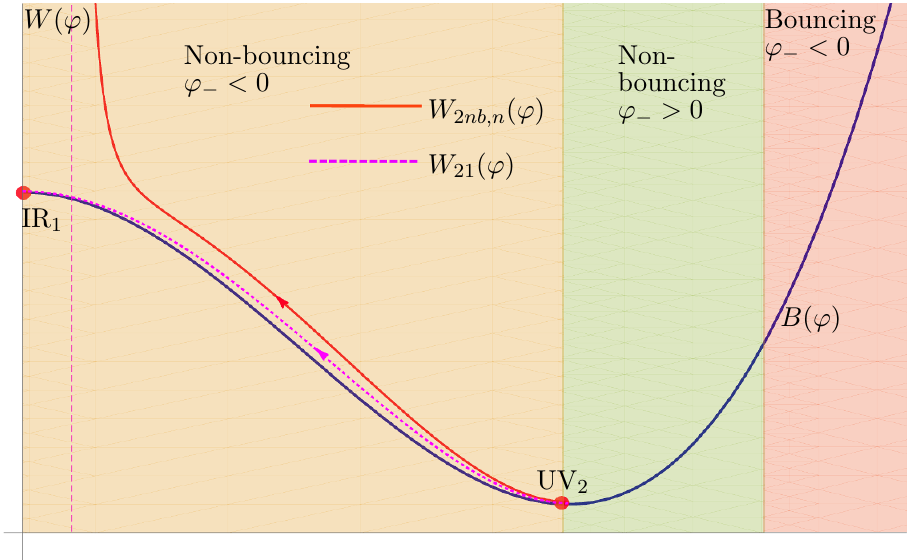
Figure 27. Superpotential W 2 nb;n ( ’ ) for a non-bouncing (cid:13)ows starting from UV 2 . In this case the source is negative. This type of (cid:13)ow comes from a curvature deformation of the (cid:13)at case (cid:13)ow W 21 and exists for all values of the curvature.